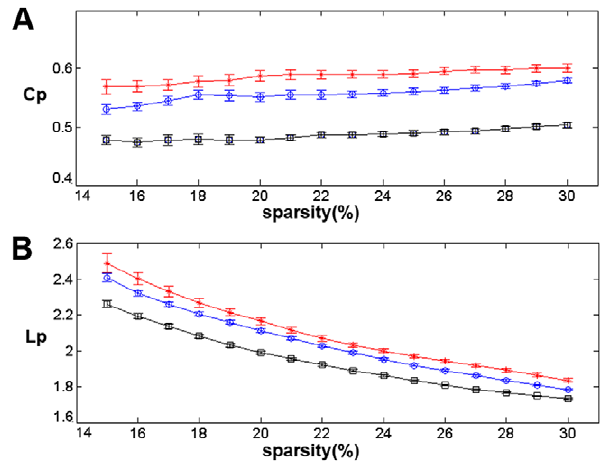
Figure 3. Mean clustering coefficients and mean absolute path lengths of the cortical networks in the three subject groups. Mean clustering coefficient (C p ) and mean absolute path length (L p ) over a wide range of sparsity values ( 15% ƒ S ƒ 30% ) and the error bars were obtained using bootstrap method. A - The red stars represent the mean clustering coefficient in the AD group. The blue circles represent the mean clustering coefficient in the MCI group. The black squares represent the mean clustering coefficient in the NC group. B - The red stars represent the mean absolute path length in the AD group. The blue circles represent the mean absolute path length in the MCI group. The black squares represent the mean absolute path length in the NC group. The mean clustering coefficient was the greatest for the AD group and the absolute path length was shortest for the NC group. The measurements of the MCI group were intermediate between the NCs and ADs.